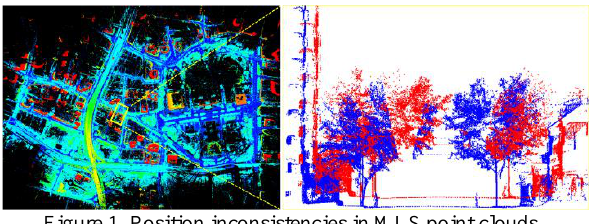
Figure 1. Position inconsistencies in MLS point clouds, the red and blue point clouds are collected by the back and forth scans in different